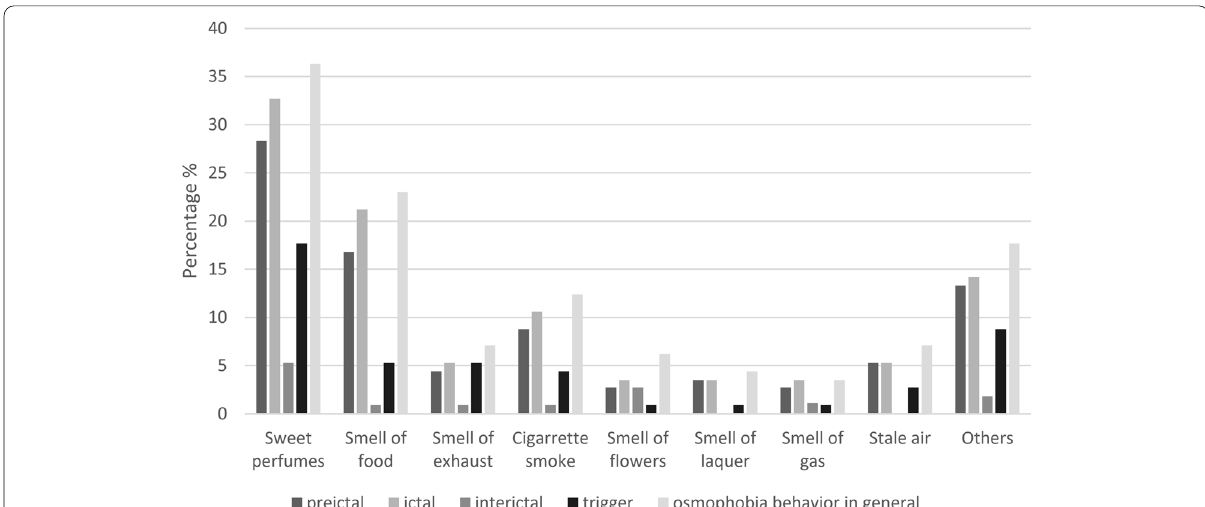
Fig. 1 Frequencies of the main odorants involved in osmophobia. The questions asked to investigate osmophobia were: “Question 1) Are you sensitive to odors before a migraine attack?”, “Question 2) Are you sensitive to odors during a migraine attack?”, “Question 3) Are you sensitive to odors on days without migraine?” and “Question 4) Can odors trigger migraine attacks in